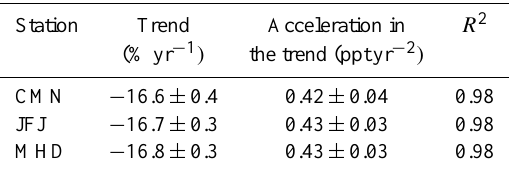
Table 1. MCF atmospheric trends (%) and acceleration in the trend at the three stations from January 2002 to December 2012.